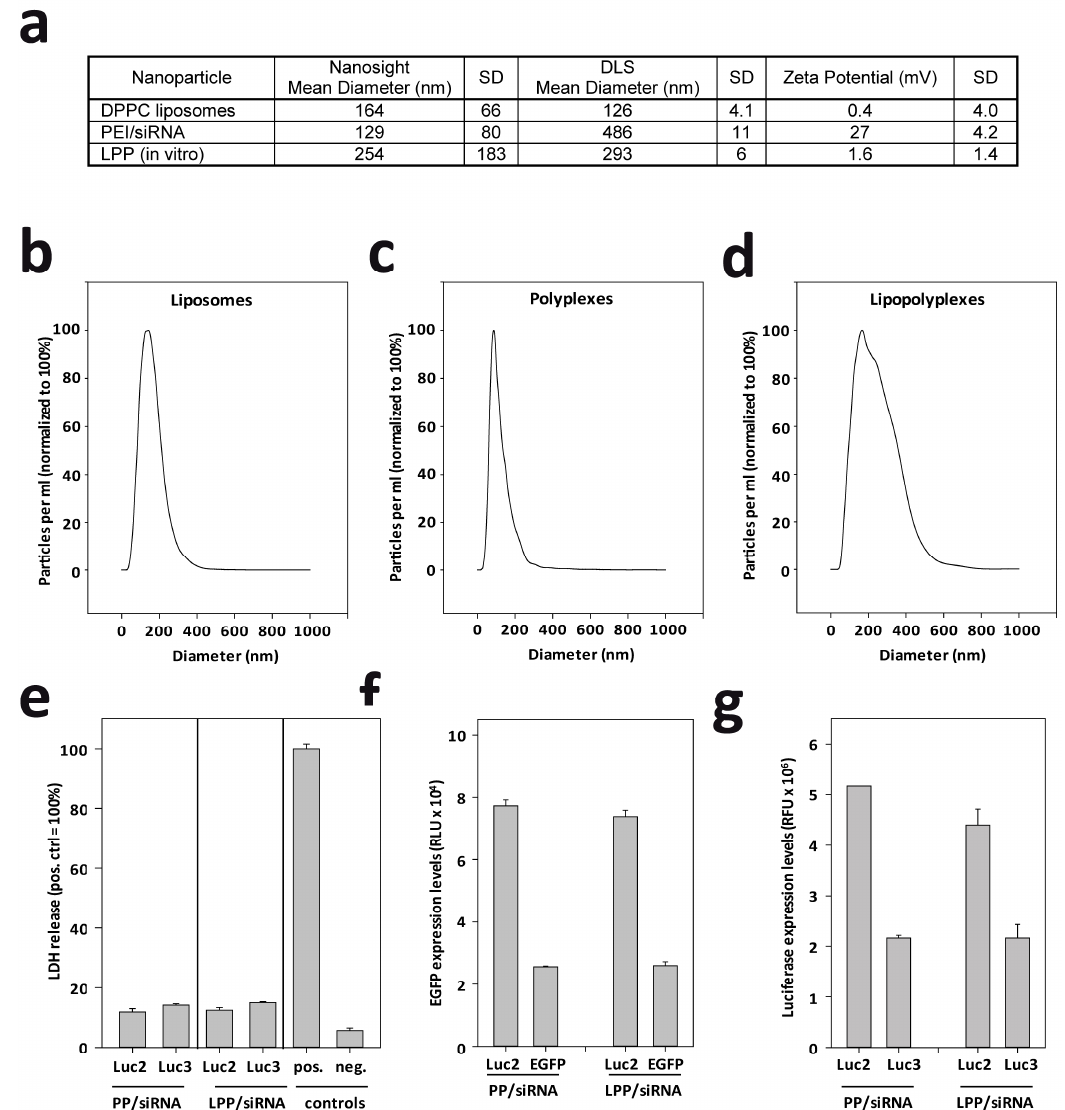
Figure 1. ( a ) Compilation of nanoparticle sizes and zeta potentials, as determined by Zetasizer